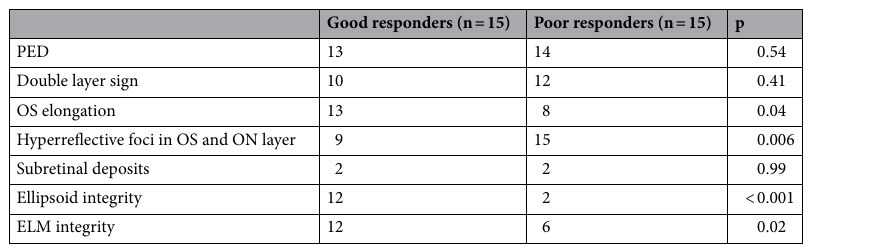
Table 4. Baseline OCT characteristics of the two study groups. PED pigment epithelial detachment, OS outer segment, ON layer outer nuclear layer, ELM external limiting membrane. p value calculated using chi-squared